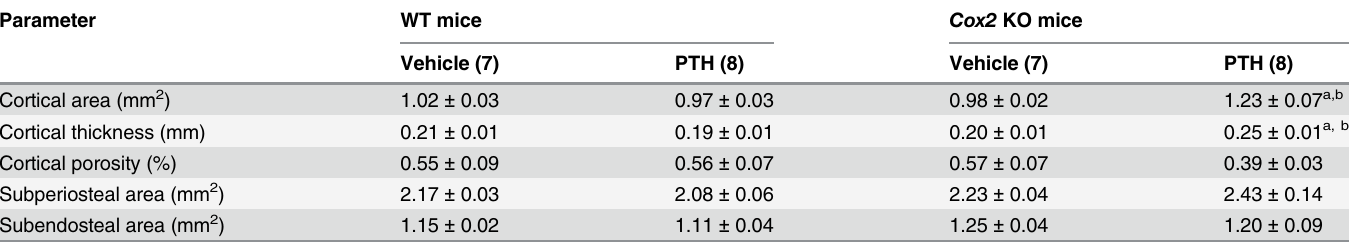
Subendosteal area (mm 2